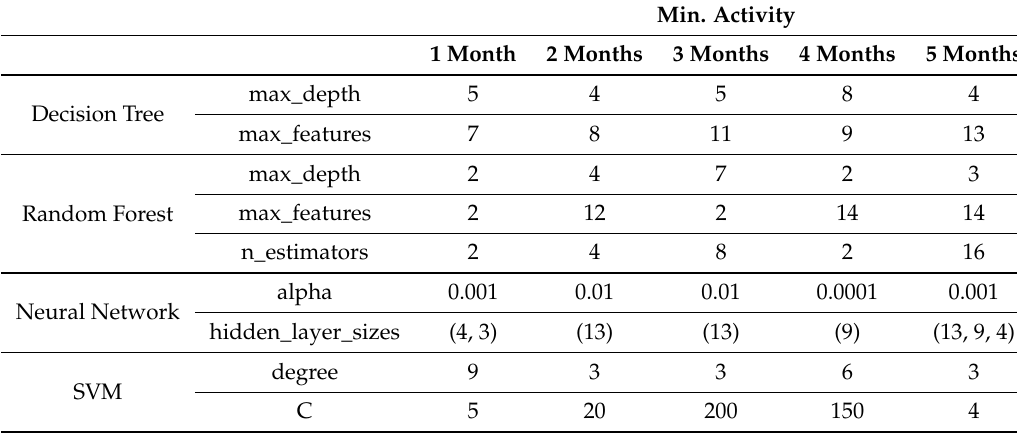
Table A25. The best values of the hyperparameters for the models which uses the full set of features for the Enron dataset with three hierarchy